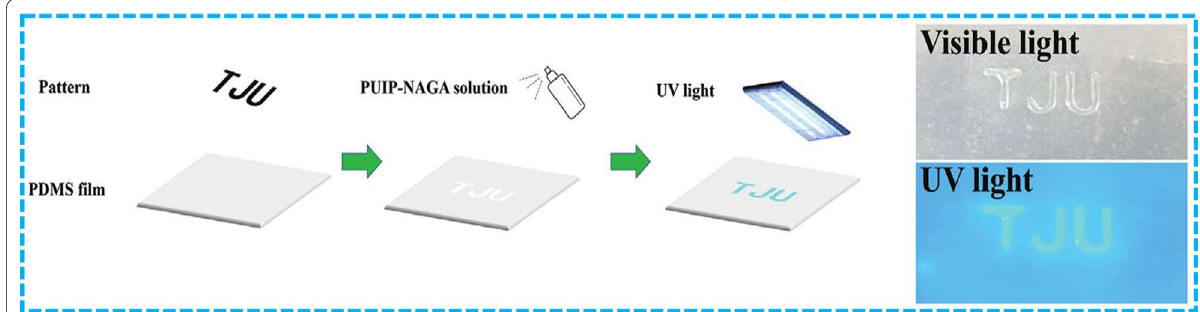
Fig. 14 Anti-counterfeiting patterns and their photographs under UV and visible light. Reprinted with permission from Reference [37]. Copyright 2021, John Wiley and Sons